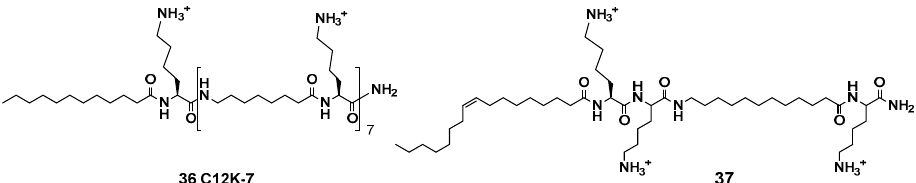
Figure 6. AMP analogs; acyllysine oligomers (OAKs) with alternating acyl (A) and lysine (K) units.